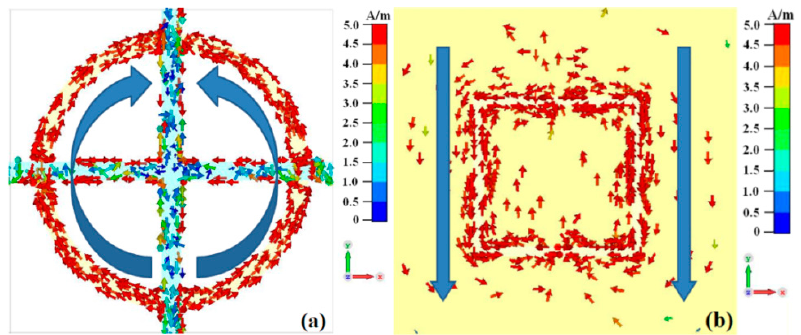
Figure 5. The surface current distribution at 11 GHz when the rotatable metal plate is parallel to the rest of the layers, ( a ) the top copper metal ring, ( b ) the metal substrate. The surface current distribution of the switchable rasorber/absorber at the transmis ‐ sion frequency of 10.31 GHz, when the rotatable metal plate is perpendicular to the rest of the layers, is shown in Figure 6. The surface currents on the left and right sides of the top copper metal ring are parallel to the upward direction. This parallel current will cause